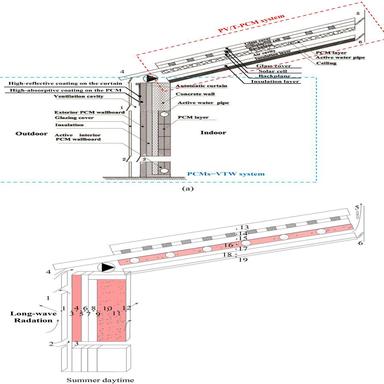
(a) Schematic diagram of the PCMs-VTW and the PV/T-PCM system . (b) Computational nodes . (Note: node 1 is the glazing; nodes 3, 4 and 5 indicate the exterior PCM wallboard; node 6 indicates the insulation layer; nodes 7 and 8 indicate the concrete wall; nodes 9, 10, 11 and 12 indicate the interior PCM wallboard; node 13, 14 and 15 indicate the glass cover, the solar cell and the blackplane; node 16, 17, 18 and 19 indicate the PCM layer, the air cavity, the insulation layer and t